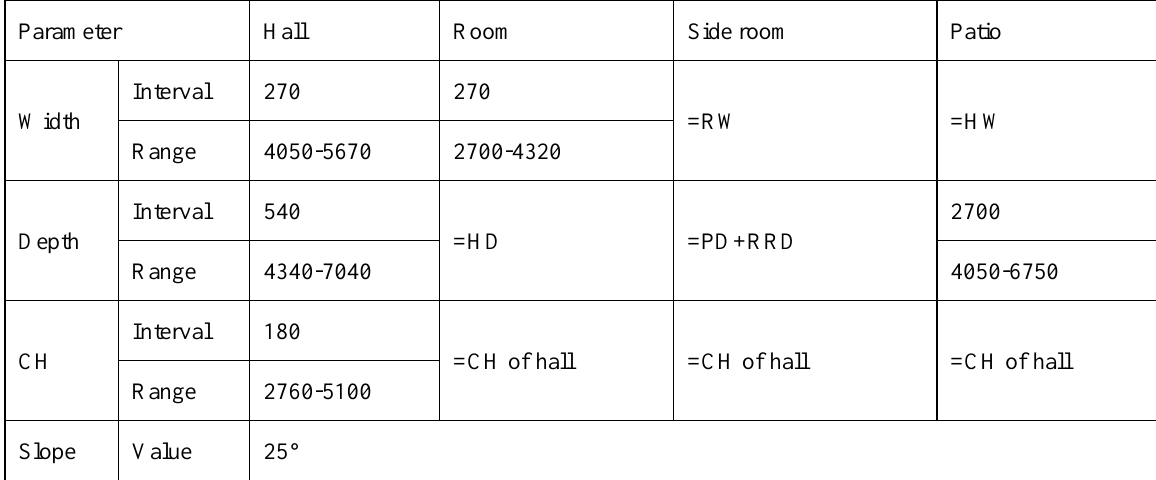
Figure. 7 The height of Xiashanhu houses (h: CH) Table 2. The building parameters of Xiashanhu houses (mm)